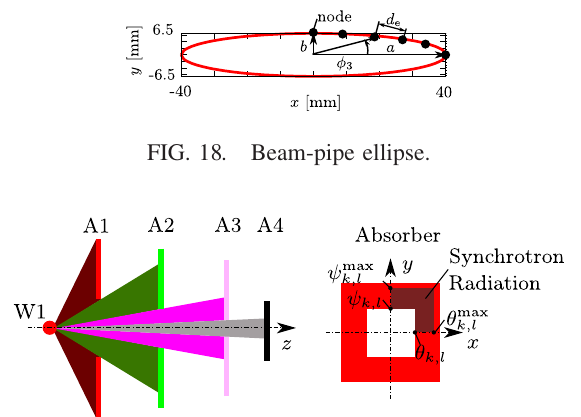
FIG. 19. Example for an absorber scheme. Left: Heat load from each wiggler magnet k (here k ¼ 1 ) on each absorber l (here l ¼ 1 ; 2 ; 3 ; 4 ). The heat load from additional wiggler magnets can be superimposed. Right: